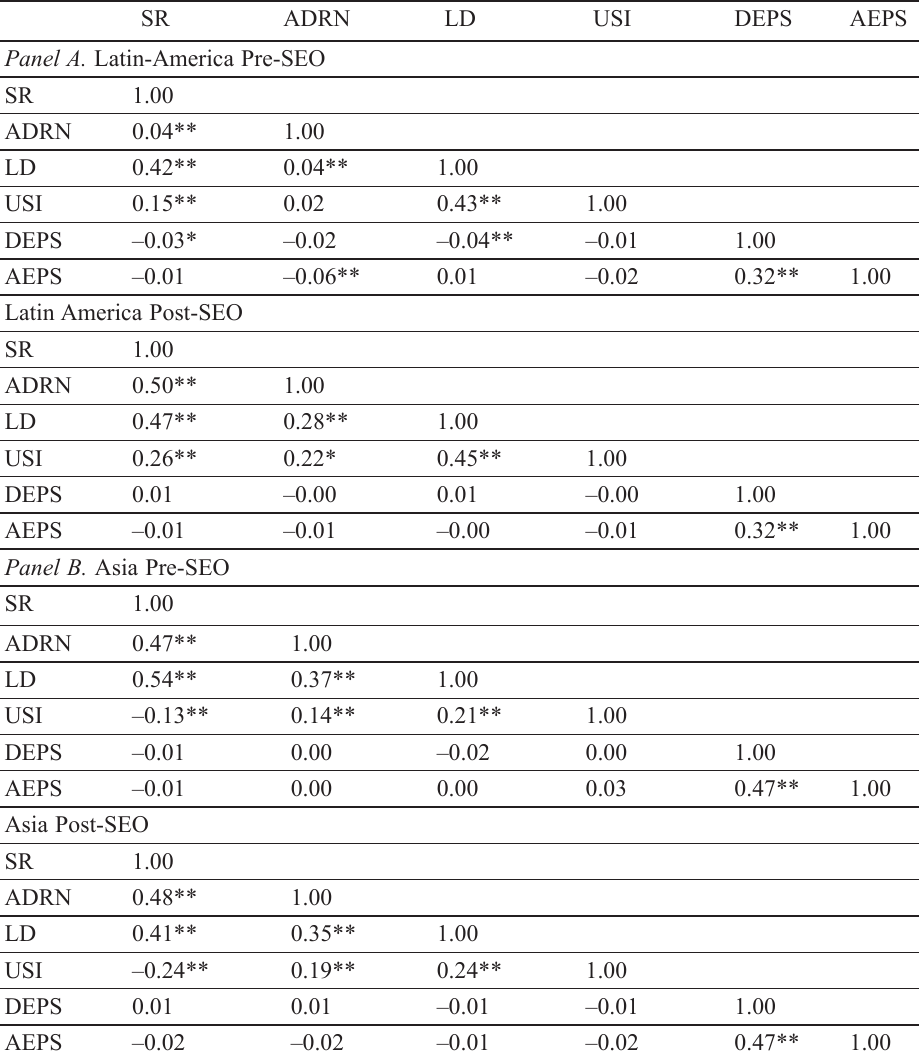
Table 7. Correlation coef fi